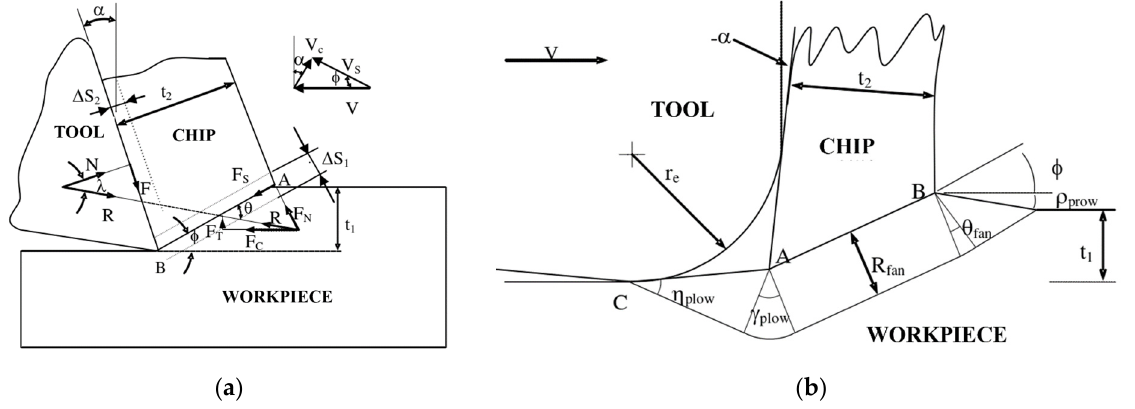
Figure 4. Geometry of the milling force model. ( a ) Chip-forming force model [15]. ( b ) Ploughing force model [34] .